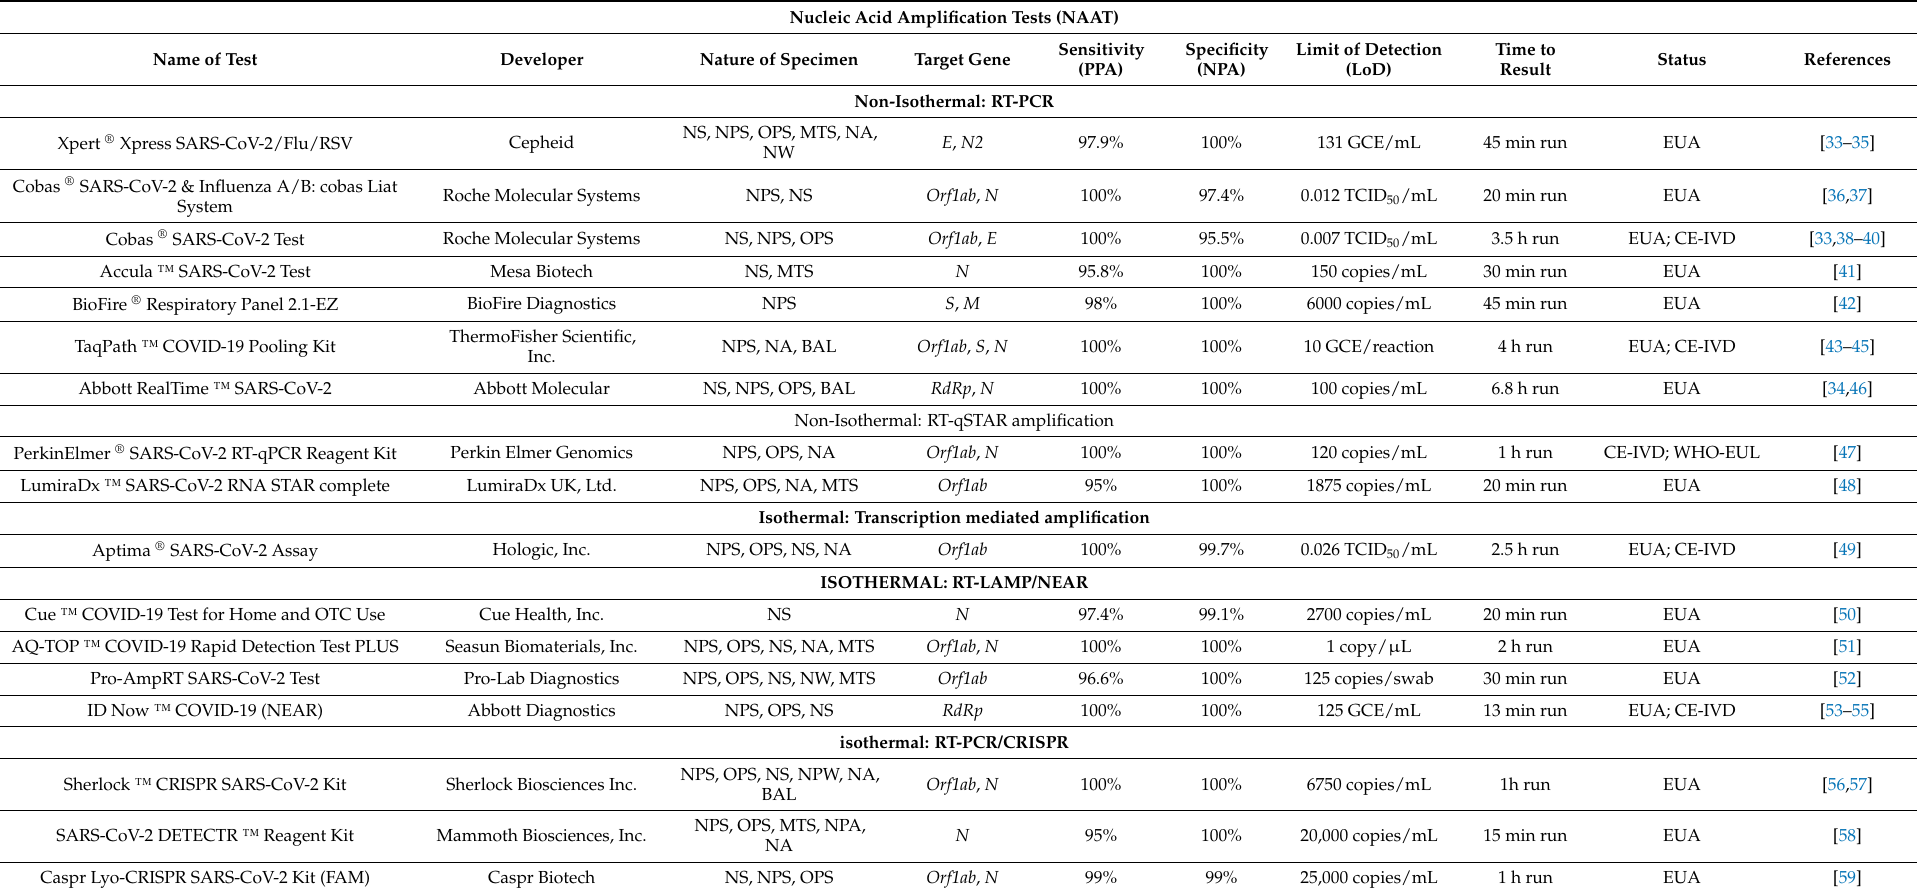
Table 1. Comparative list of nucleic acid amplification tests for the detection of SARS CoV-2, by manufacturer, origin of specimen, target gene, sensitivity, specificity, limit of detection and the time to produce one successful